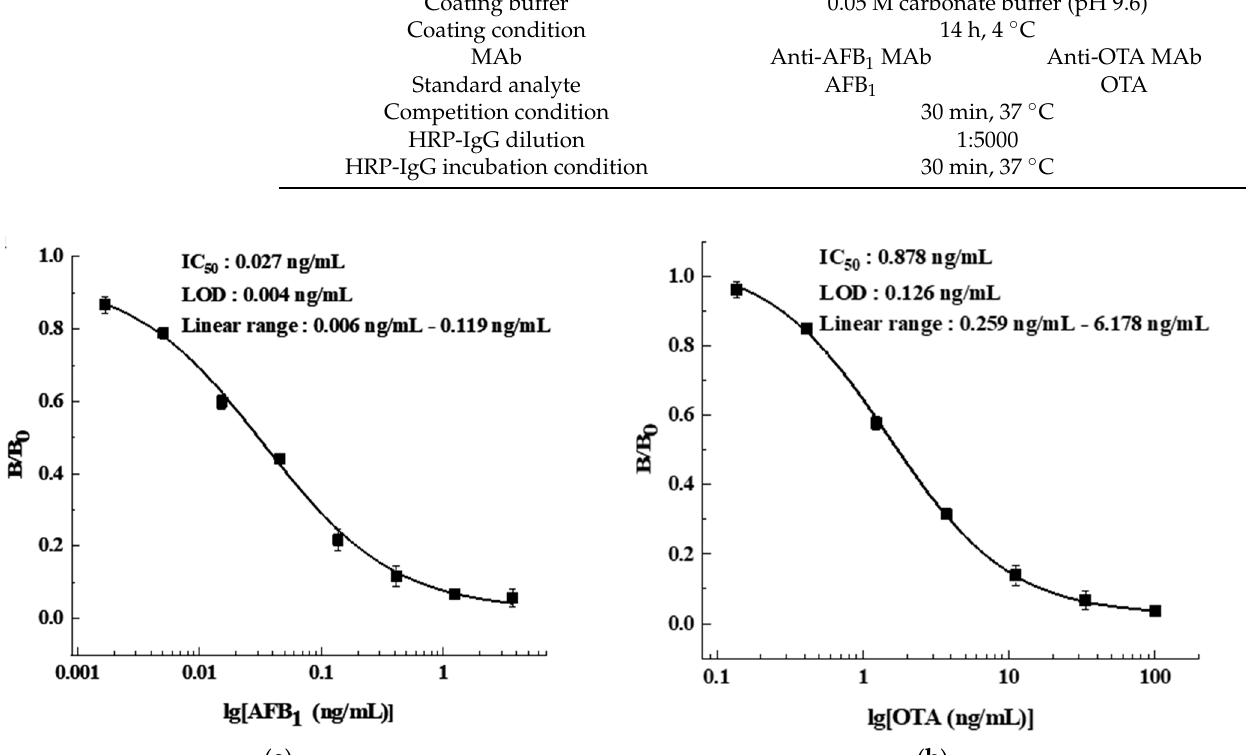
Figure 1. The inhibition curve of ic-ELISA: ( a ) AFB 1 ; ( b ) OTA.